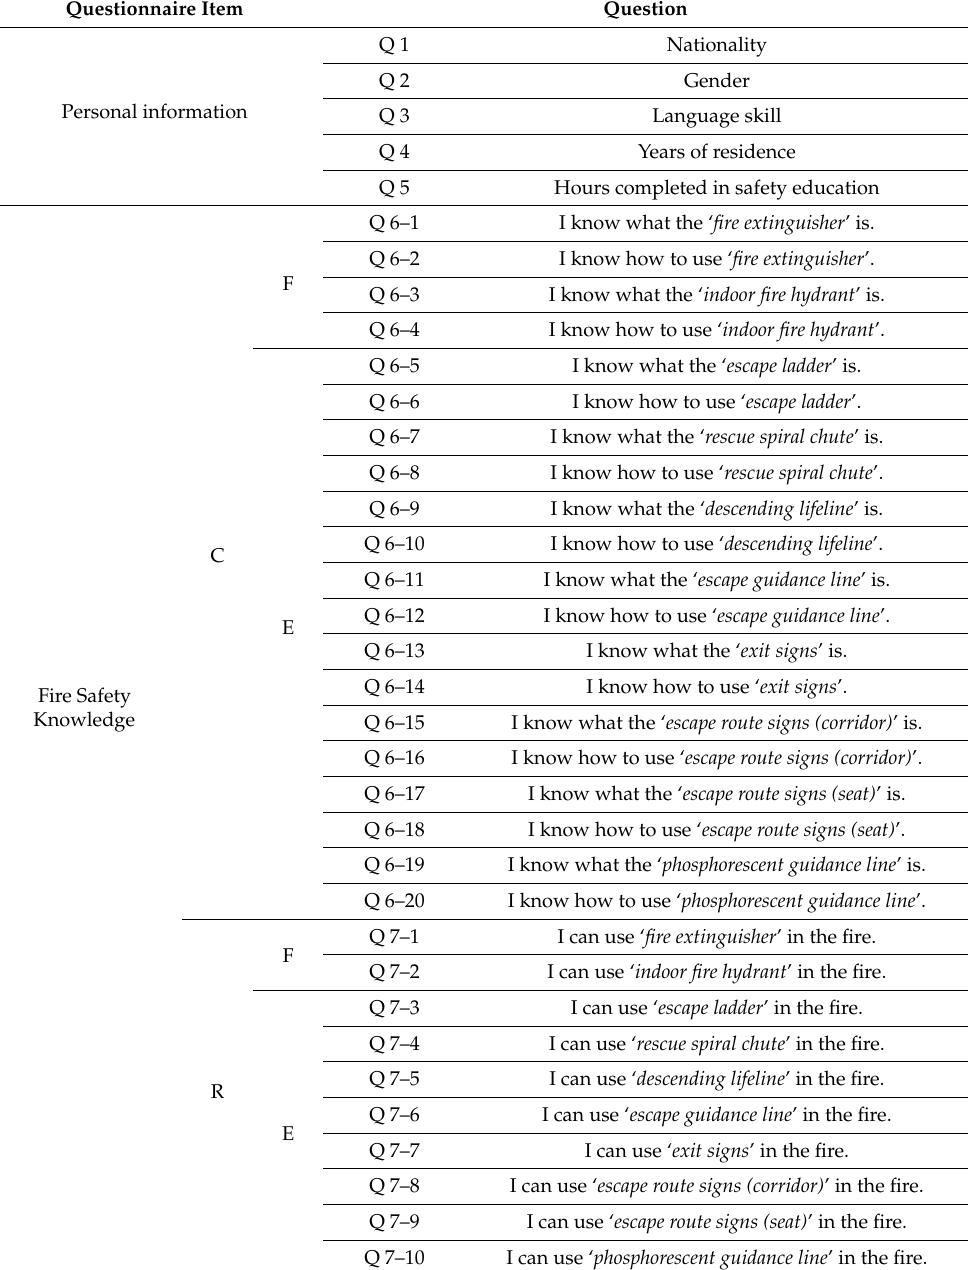
Table 1. Questionnaire